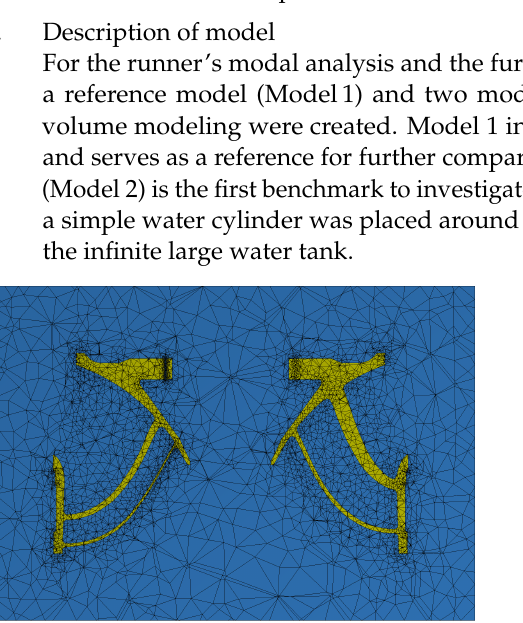
Figure 9. FE model of the cylinder model (Model 2).